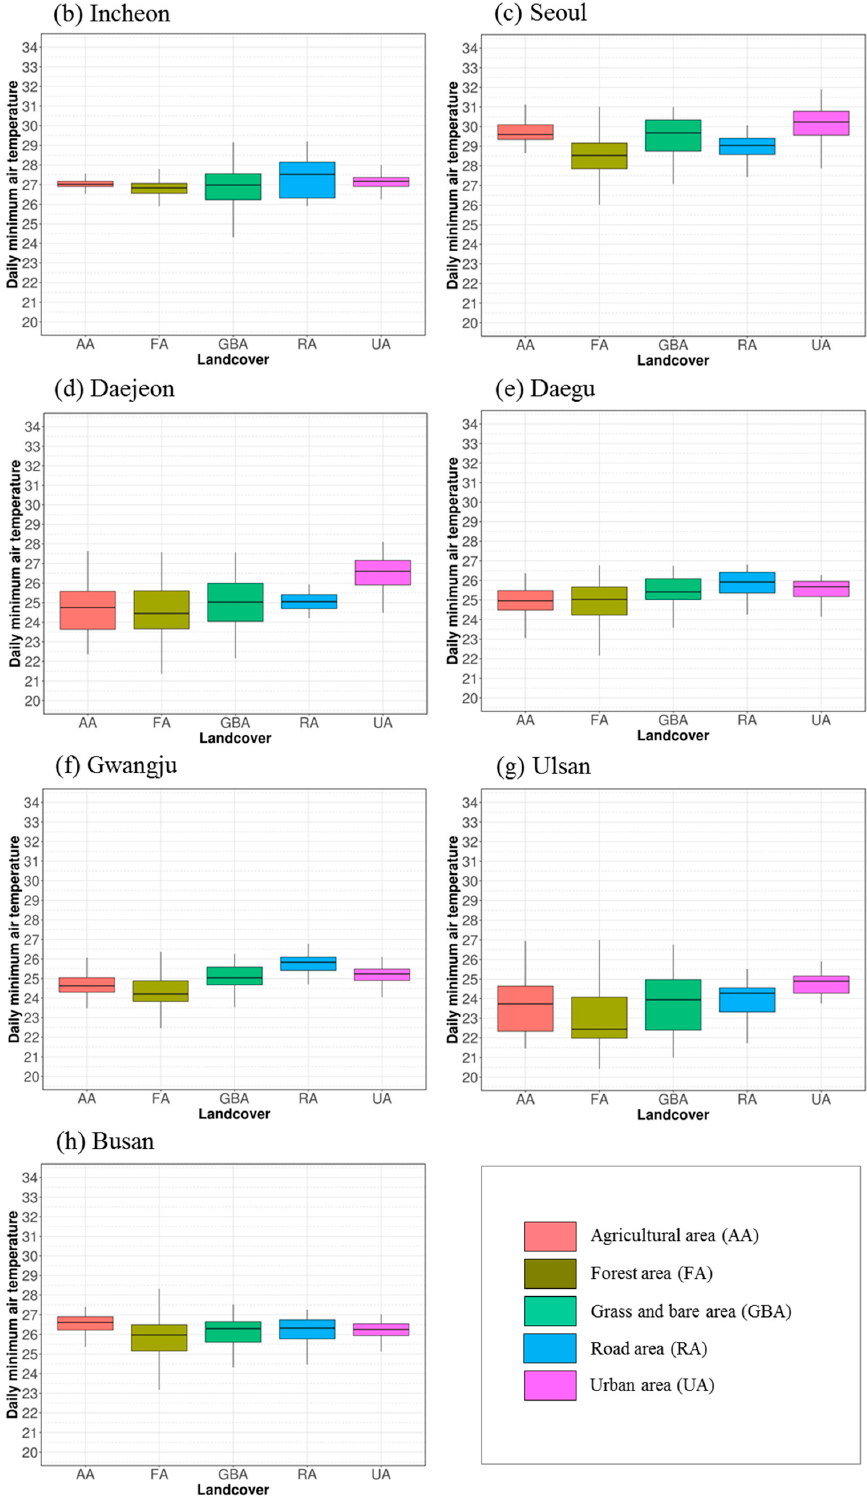
Figure 9. Daily maximum temperature distribution on 1 August 2018 with respect to the land use in each city. ( b ) Incheon; ( c ) Seoul; ( d ) Daejeon; ( e ) Daegu; ( f ) Gwangju; ( g ) Ulsan; ( h ) Busan. ( b – h ) are the analysis areas shown in Figure 1.